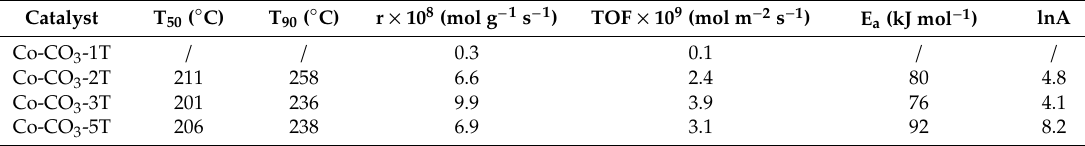
Figure 7. ( a ) Propane conversion to CO 2 , ( b ) CO concentration, and ( c ) propene concentration as a function of the reaction temperature in the oxidation of propane over the catalysts. Table 2. Catalytic performance and kinetic analysis of the catalysts for propane oxidation.